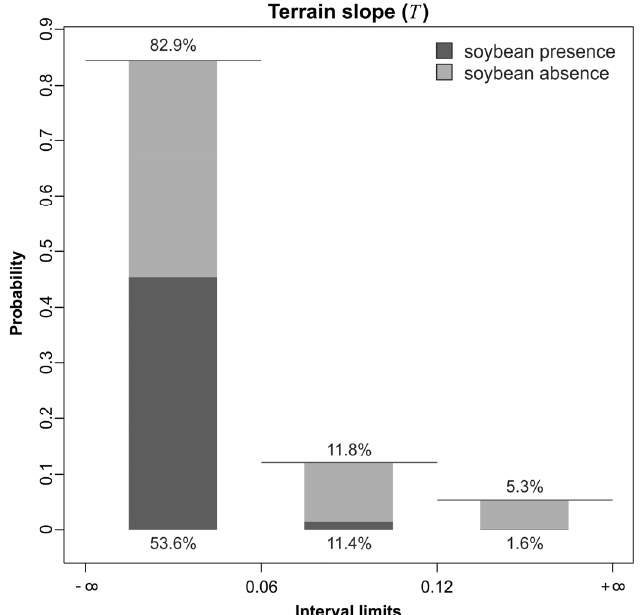
Figure 5. Discretization of context variable terrain slope ( T ) into three intervals. The percentage at the top of each bar represents the probability of finding a pixel within the defined interval limits, e.g., P( −∞ ≤ T = t < 0.06) = 82.9%; and the percentage at the bottom of each bar represents the conditional probability of soybean presence given